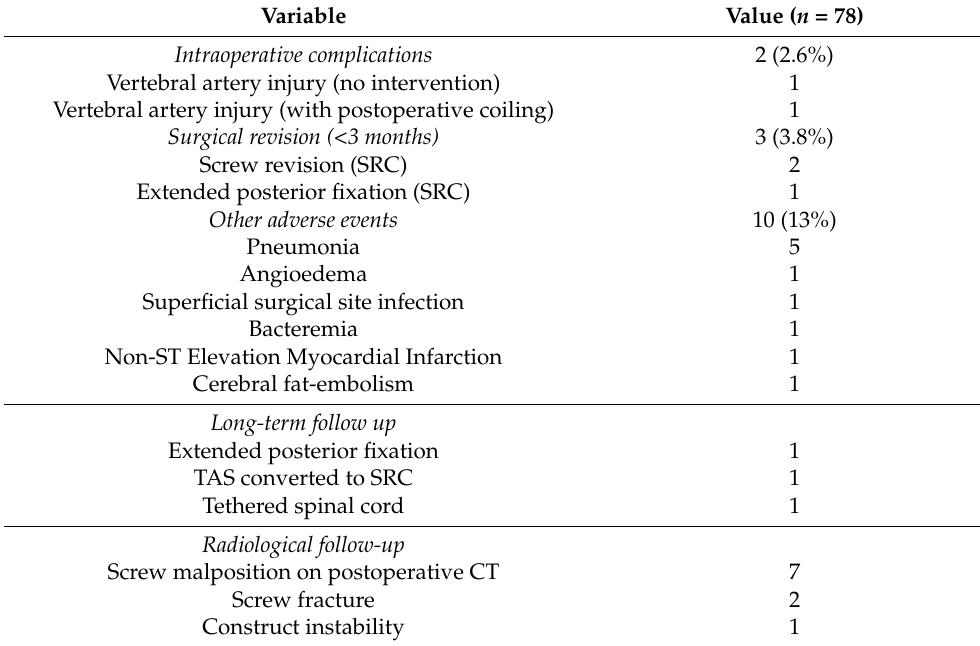
Table 3. Treatment outcome.